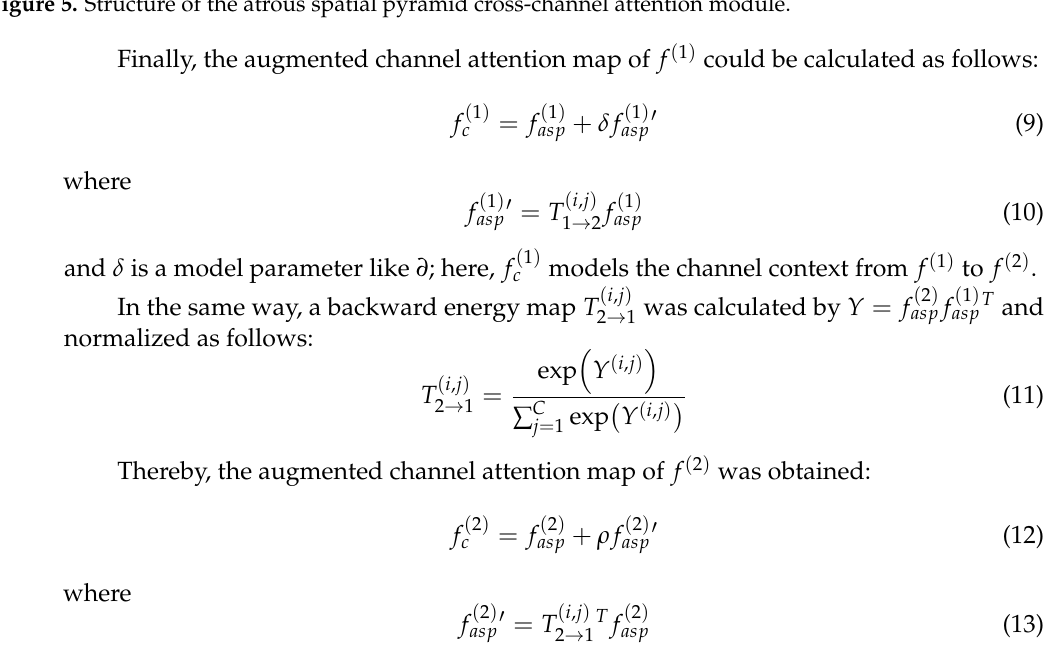
Figure 5. Structure of the atrous spatial pyramid cross-channel attention module.